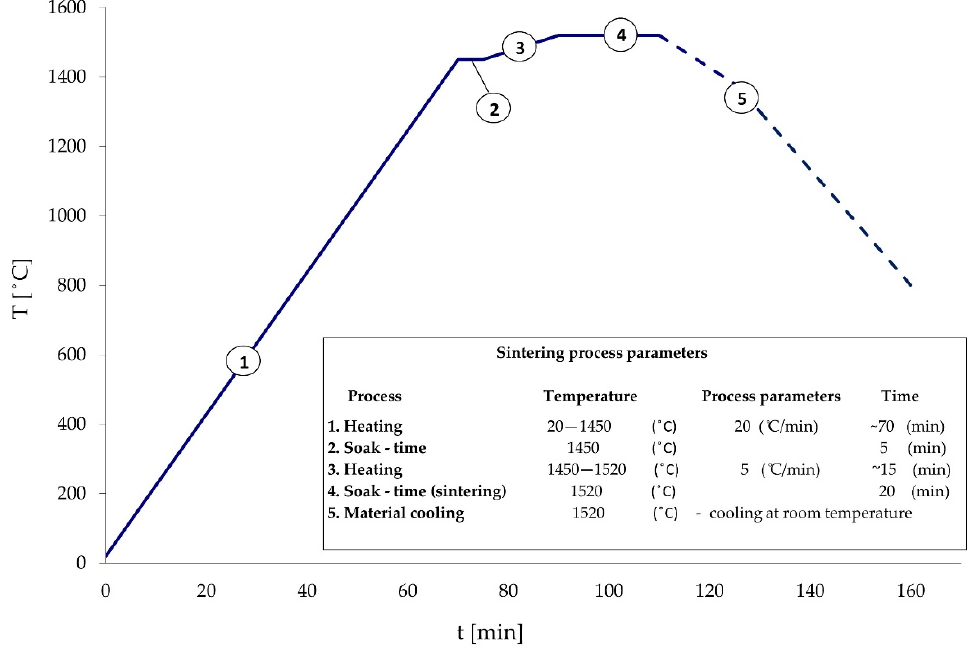
Figure 2. Sintering temperature diagram.